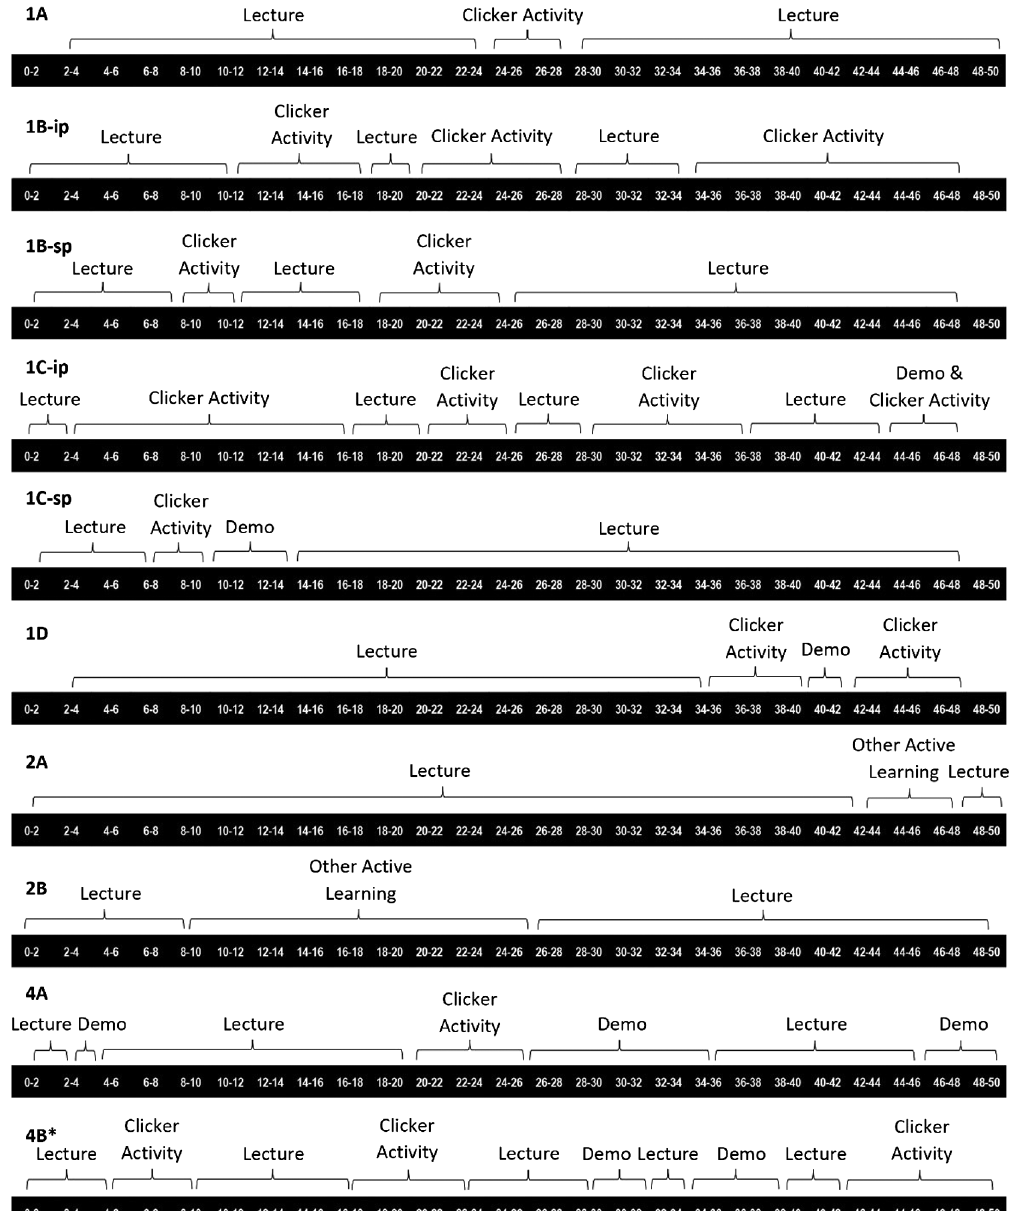
FIG. 1. Sample segmenting for each subcategory. In the top left corner, the subcategory the timeline represents is noted (see list of categories and subcategories in Table II). The center black bar shows the 2-min time intervals during an observation. The brackets indicate the teaching strategy used in that time interval. The combined “ Demo & Clicker Activity ” brackets are used to visualize clicker activities based on a demonstration, but the time spent on each individual teaching strategy was noted during the observation and used in our analyses. The asterisk on the last timeline denotes that this timeline shows the first 50 min of an 80-min observation. The corresponding full timelines for each segmented sample in this figure are in the Supplemental Material